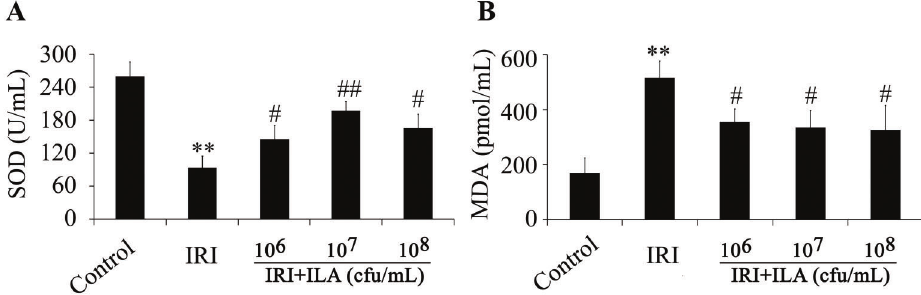
Figure 2. Effect of different concentrations of inactivated lactobacillus (ILA) on the levels of superoxide dismutase (SOD) ( A ) and malondialdehyde (MDA) ( B ) in occipital lobe tissues after ischemia reperfusion injury (IRI) (n=4). Data are reported as means ± SD. **P o 0.01 vs Control; ## P o 0.01 and # P o 0.05 vs IRI (ANOVA, followed by Duncan ’ s multiple range test).